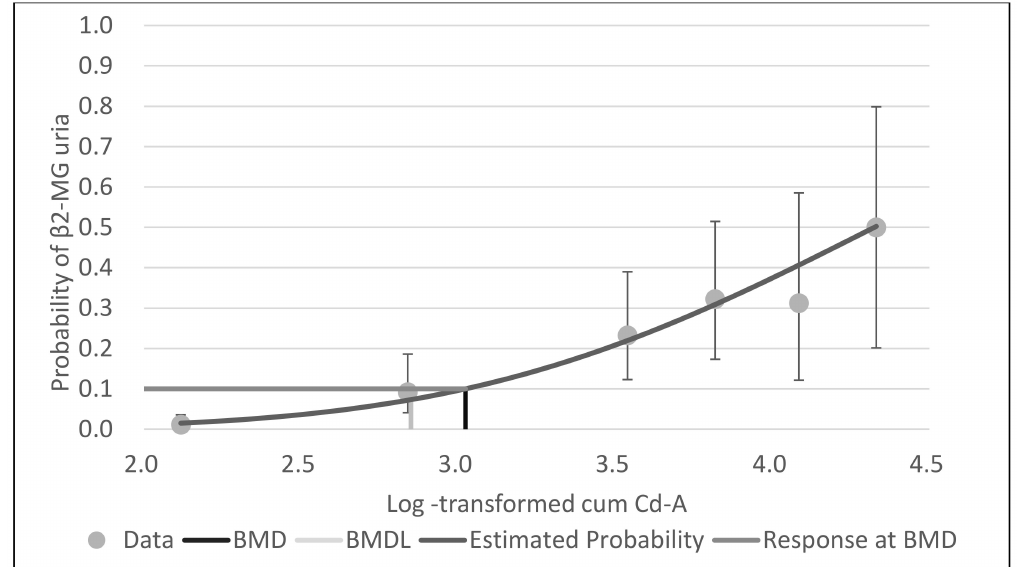
Figure 1. Probit model with BMR of 10% extra risk for the BMD and 95% lower confidence limit for the BMDL of log-transformed cum Cd-A for β 2-MG